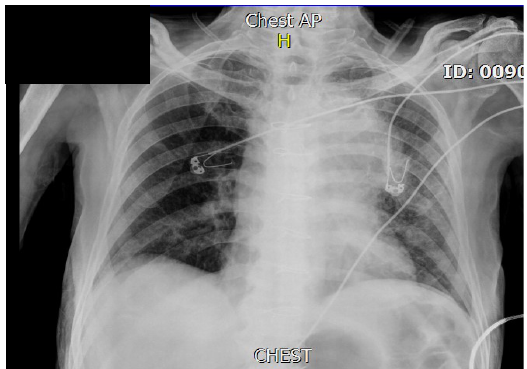
Figure1 . Antero posterior (A-P) Chest X ray